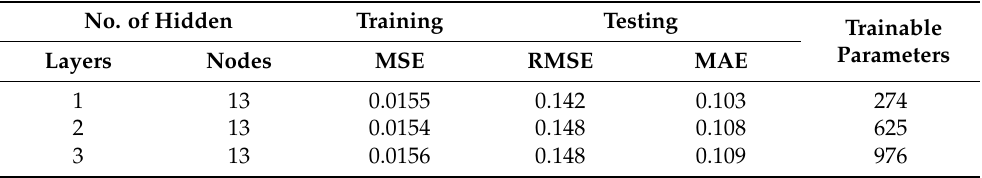
Table 13. Impact of hidden layers on the performance of the model “RDM-1”. No. of